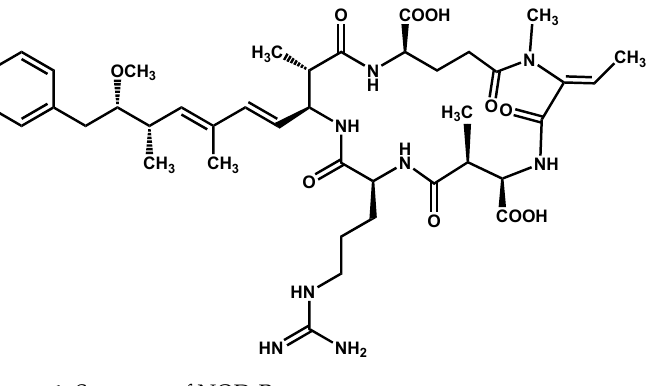
Figure 1. Structure of NOD-R.